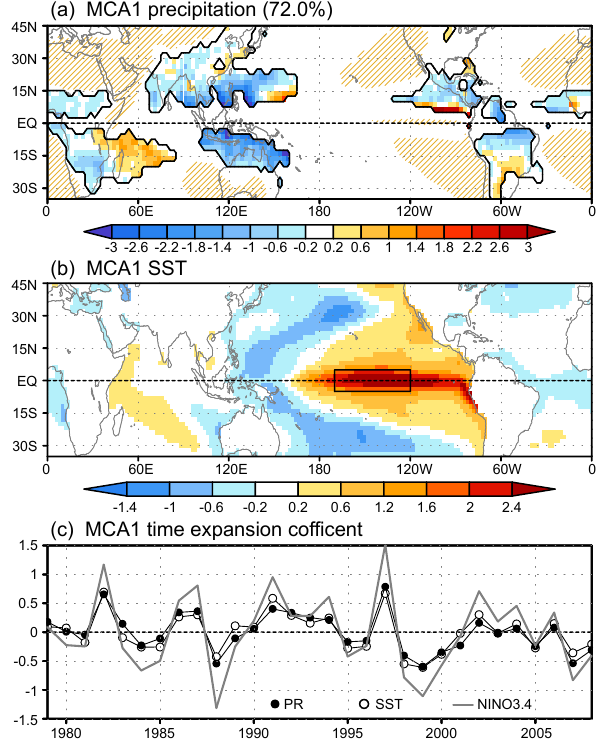
Figure 7. The leading coupled mode of monsoon-year mean pre- cipitation rates (mmday − 1 ) in GM domains and the corresponding global SST (K) derived by maximum covariance analysis, which ex- plains about 72% of the total covariance. Spatial patterns of mon- soon precipitation (a) and SST (b) are shown together with their corresponding time expansion coefficients (c) . For comparison, the Niño 3.4 SST anomaly (an ENSO index averaged over the box inserted into panel (b) ) averaged over the monsoon years is also shown in panel (c) . The GM precipitation domain and hatched dry regions are defined in Fig. 2. The merged GPCP–CMAP ERSST data were